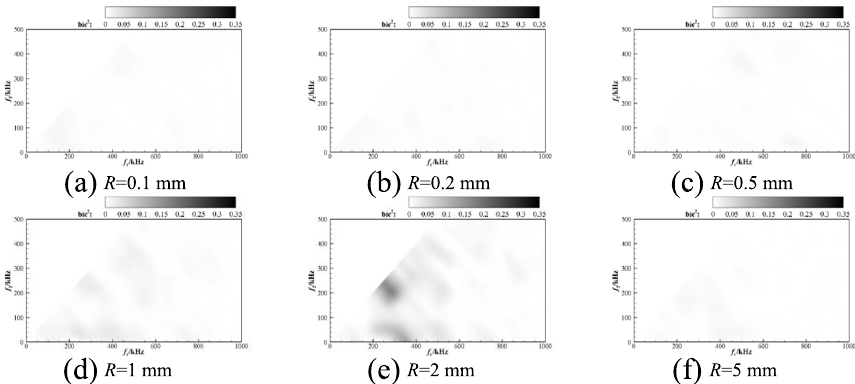
Fig. 15 Bicoherence contour of instability wave interactions measured by the PCB sensor NO. 6 at Re unit 10E = +